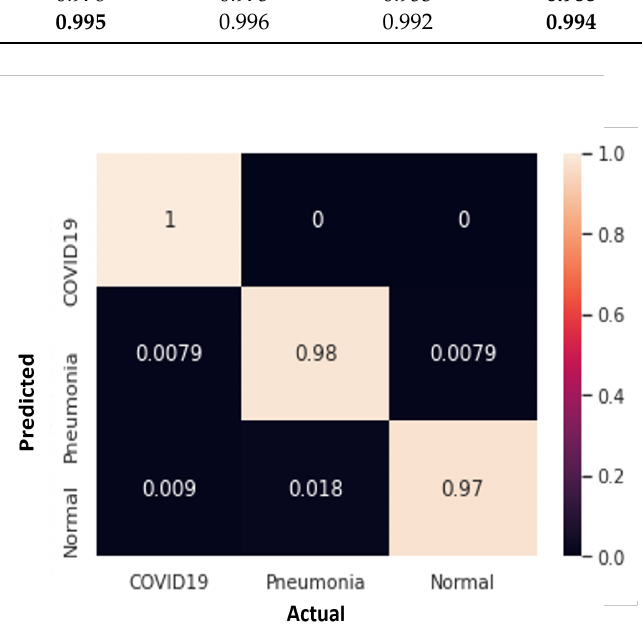
Figure 7. Confusion matrix of our proposed model for the test